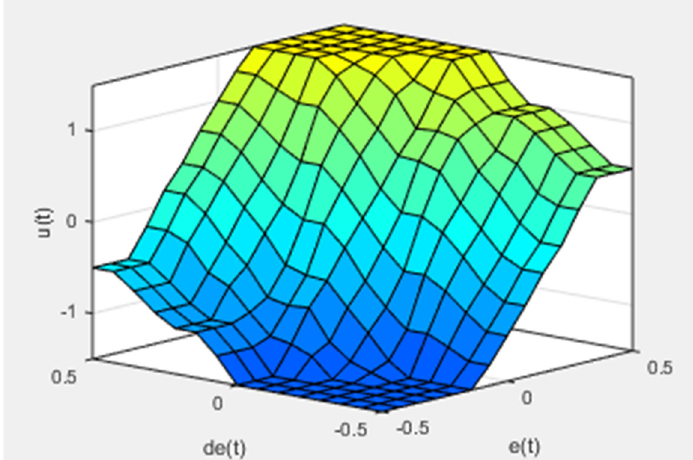
Figure 18. Control surface of the proportional-derivative action.